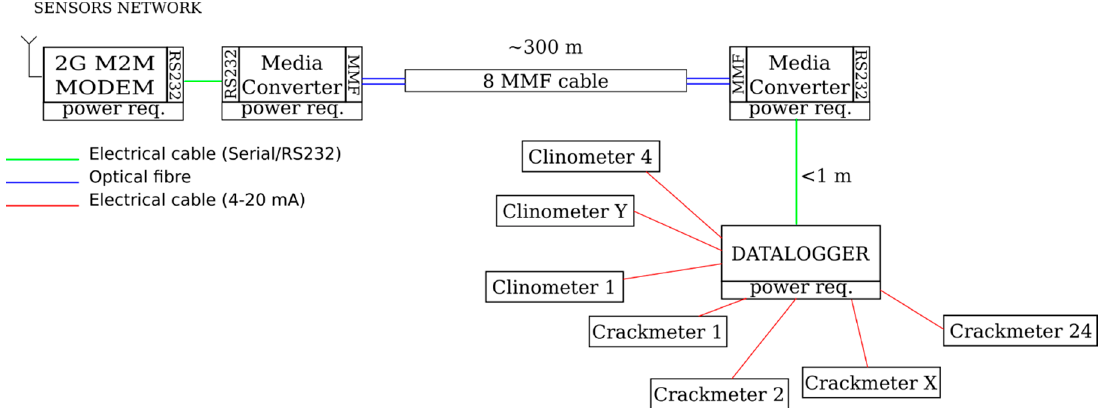
Figure 5. Scheme of the sensor sensing system. Each node of the sensing system indicates the need for the power supply and the data protocol used at each input port (2 G M2M: machine-to-machine modem enabling data transfer over a 2 G cellular network; MMF: multimode optical fibre; RS232: serial data protocol). Furthermore, the lengths of each link are reported.